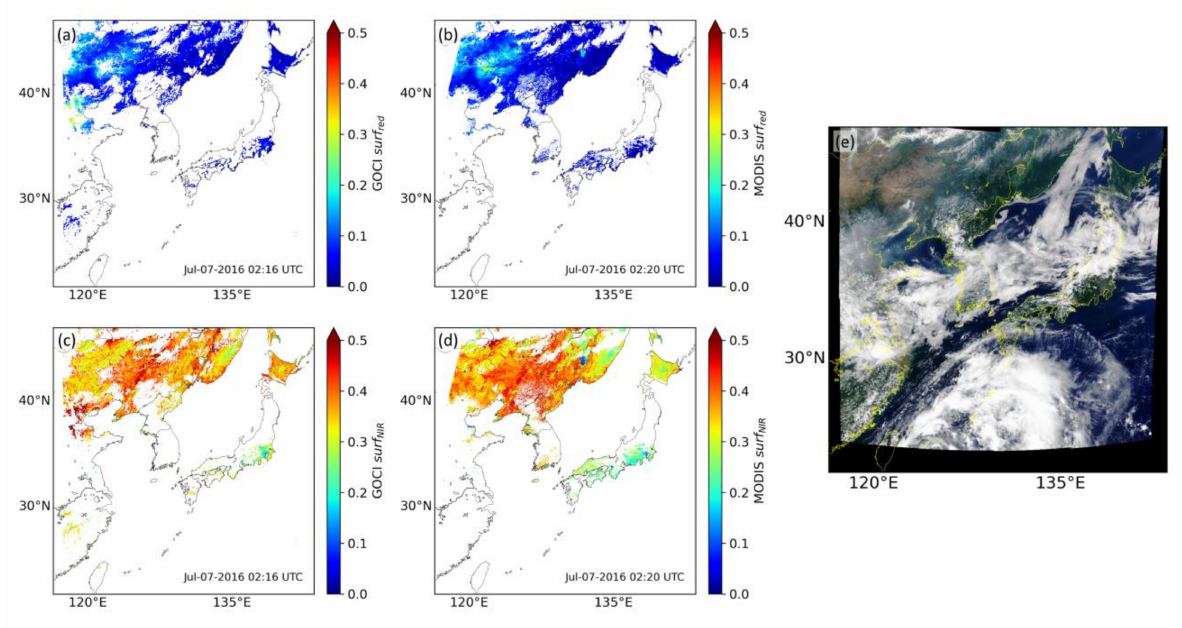
Figure 3. Same as Figure 2, but for 02:16 UTC, 7 July